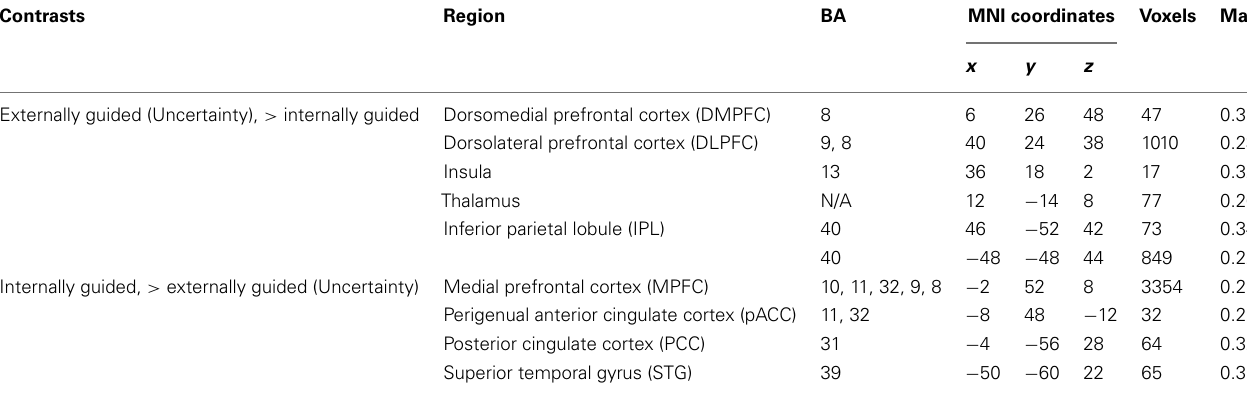
Regions marked ** were significant at FWE voxel-level corrected p < 0.05 with extent size > 10 voxels. Regions marked *were significant at FEW extent corrected p < 0.05 at primary voxel thresholds of uncorrected p < 0.001. Regions marked † were significant at FEW extent corrected p < 0.05 at primary voxel thresholds of uncorrected p < 0.01. Regions marked with* and with † were reported if these were additional